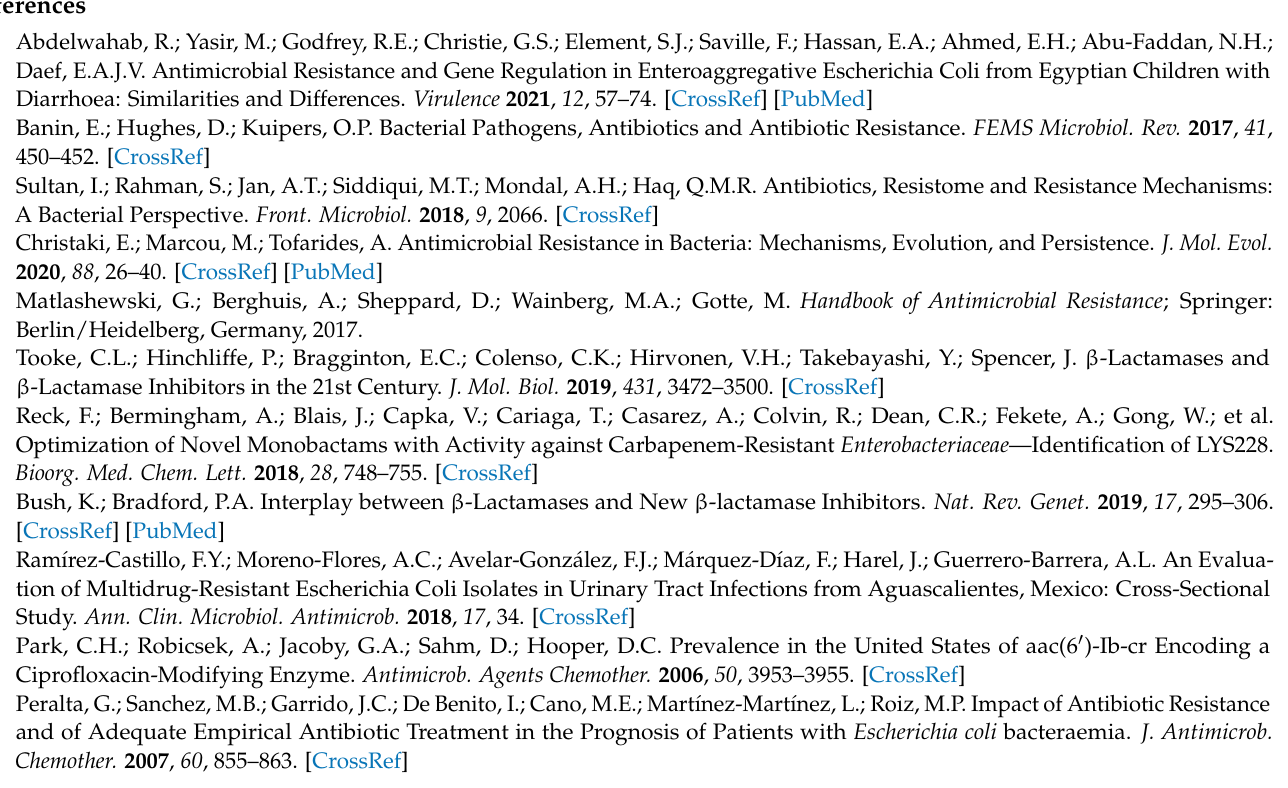
Table S3: Different serotypes of the intestinal E. coli, Table S4: Resistance pattern of ESBLs and MBLs producers, Table S5: Correlation coefficient of the number of detected genes in isolates with the resistance of the antibiotics, Table S6: Primers used in the current study. References [63–70] are cited in Supplementary